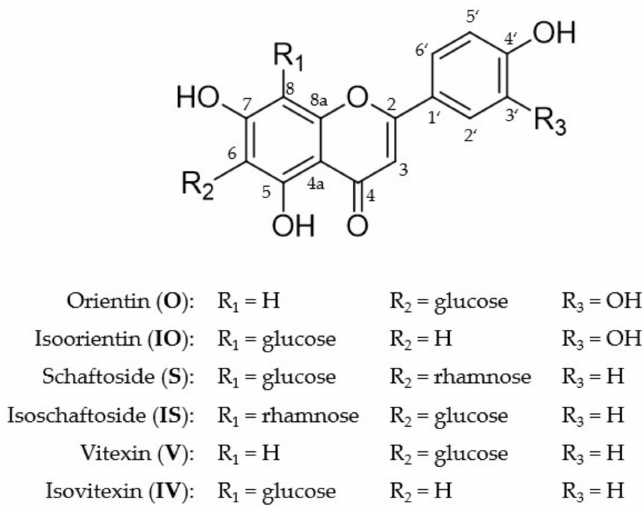
Figure 1. Chemical structures of the six flavone C-glycosides orientin (O), isoorientin (IO), schaftoside (S), isoschaftoside (IS), vitexin (V), and isovitexin